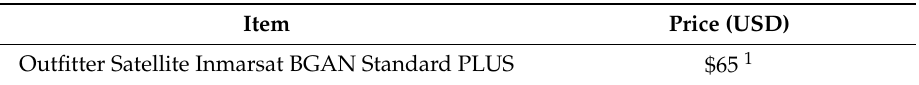
Table 5. The operation cost of using a monthly plan for under 20 MB of data